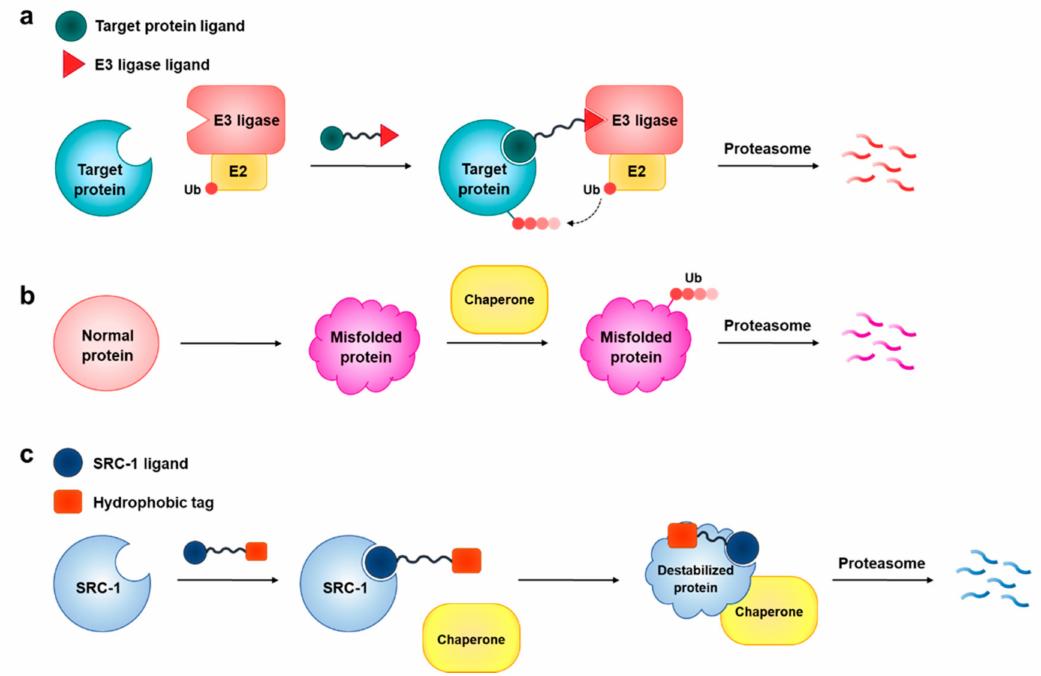
Figure 1. ( a ) Mechanism of PROTAC-mediated protein degradation. ( b ) Chaperone-assisted degradation of misfolded proteins through recognition of hydrophobic patches. ( c) Schematic showing SRC-1 degradation with a hydrophobic tagging